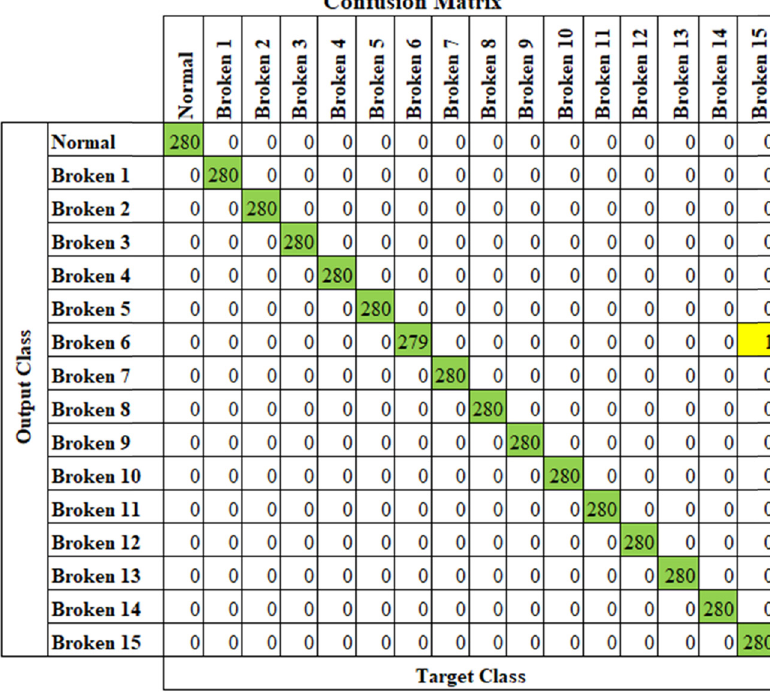
Figure 13: Confusion matrix for good performance